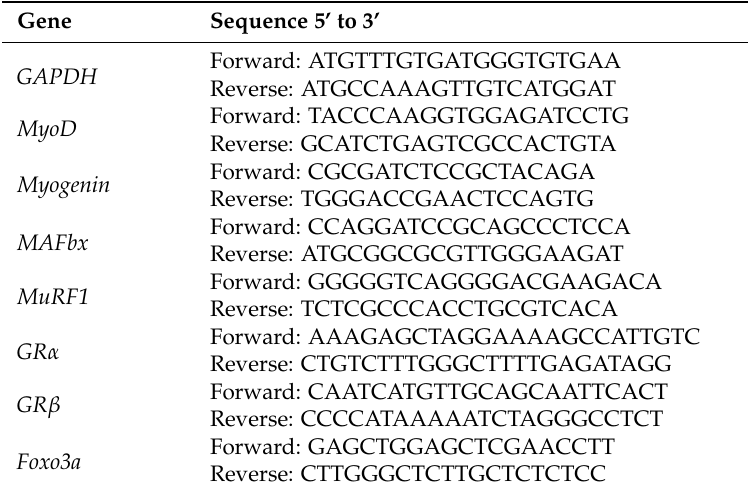
Table 1. Real-time PCR Primer